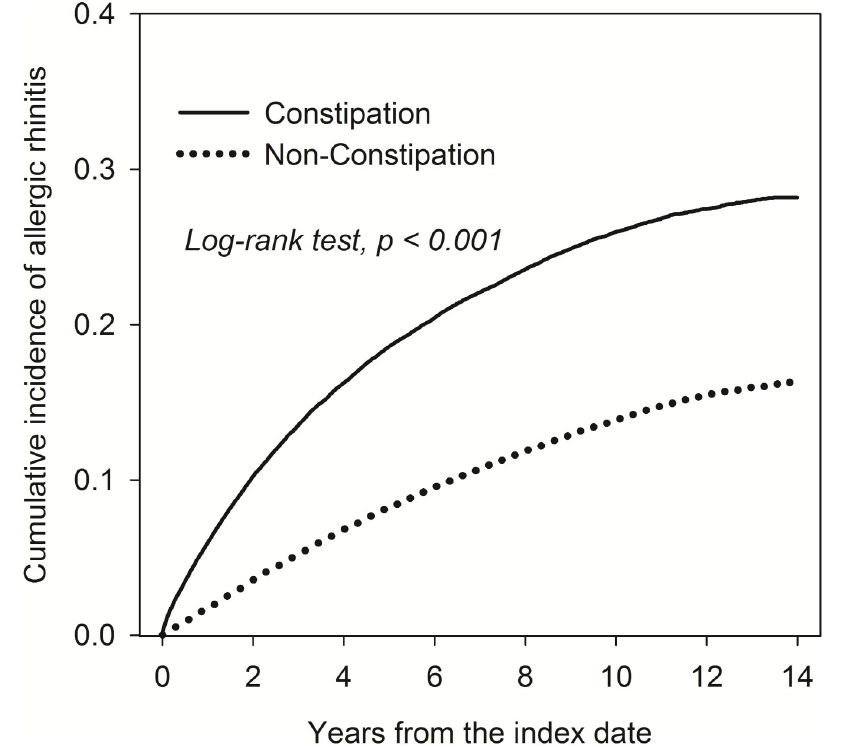
Fig 2. Kaplan–Meier curves of the cumulative probability of AR in the study